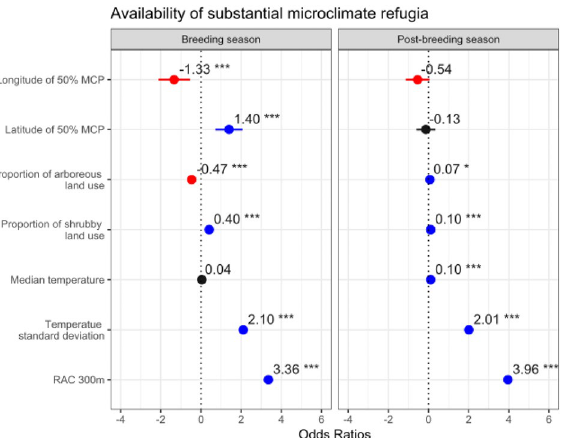
Figure 3. GLMM results for the predictors of availability of microclimate refugia, for both breeding and post- breeding seasons. Variable significancy is shown: *** p < 0.01; * 0.01 < p < 0.05; others, p > 0.05. Positive effects are shown in blue, negative effects in red and not significant effects in black.